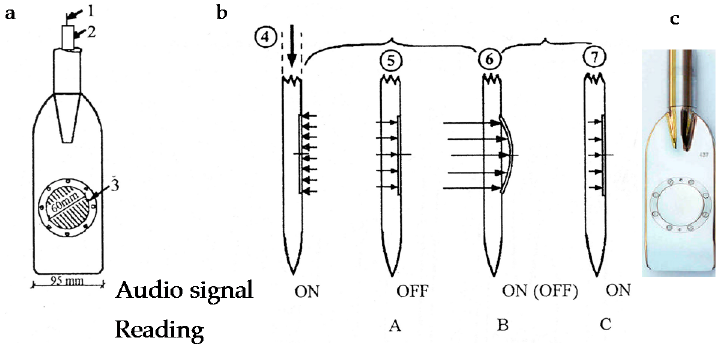
Figure 1. Marchetti dilatometer: ( a )—flat blade, 1—electric wire, 2—pneumatic tubing, 3—steel membrane, ( b )—test stages, 4—pushing, 5—contact stress p 0 , 6—expansion stress p 1 , 7—pressure p 2 , c: view of DMT blade actually used in soil in situ tests.